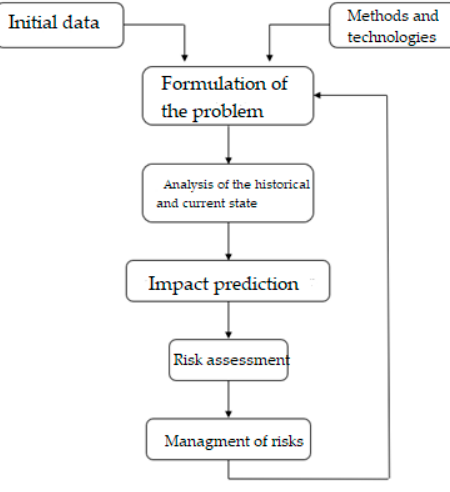
Figure 2. Stages of risk analysis and forecasting.